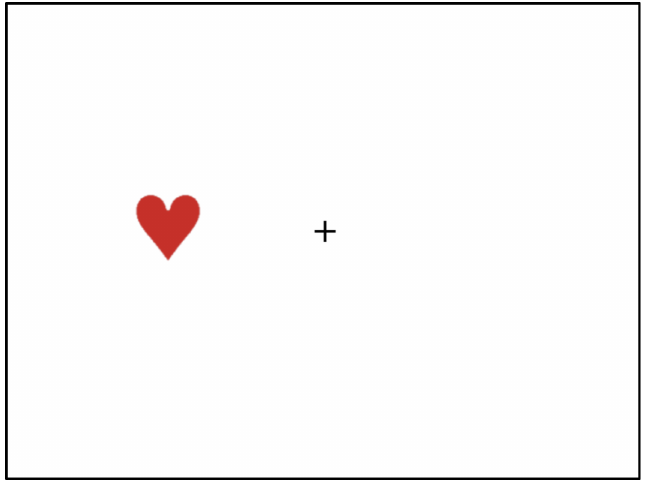
Fig 2. Example of stimulus from Hearts and Flowers task, a measure of task switching